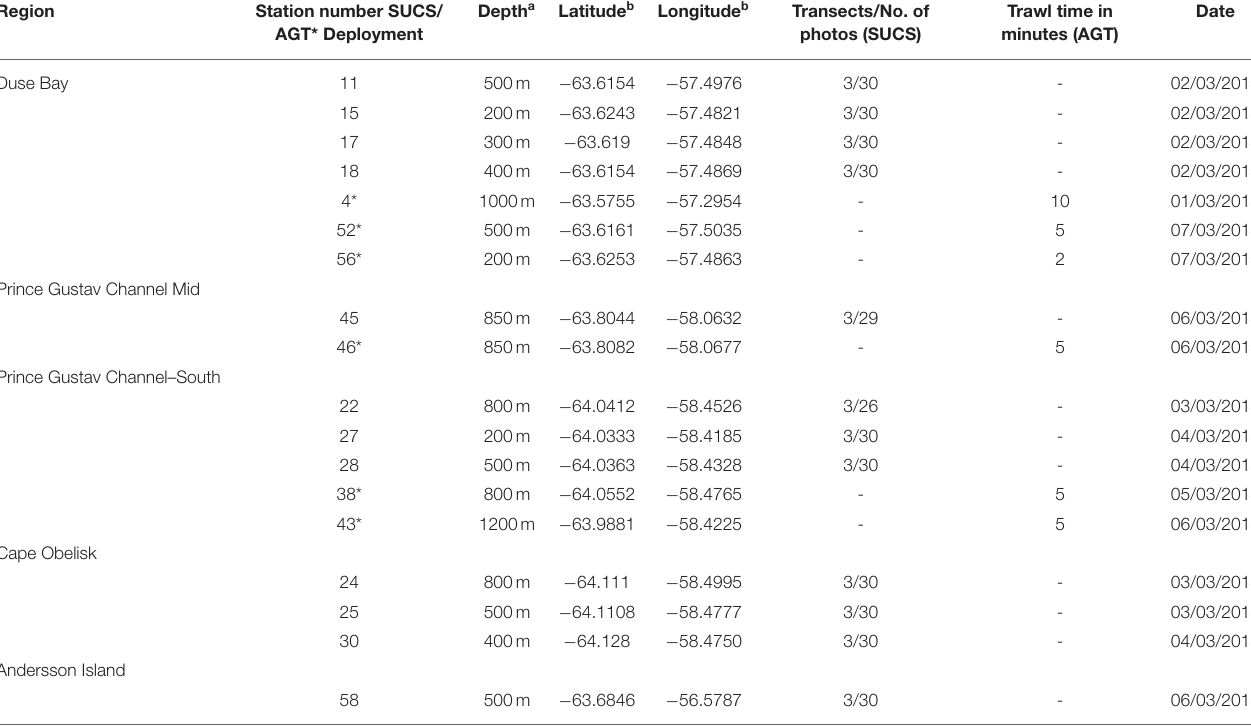
TABLE 1 | Station details for SUCS and AGT deployments. Region Station number SUCS/ AGT*